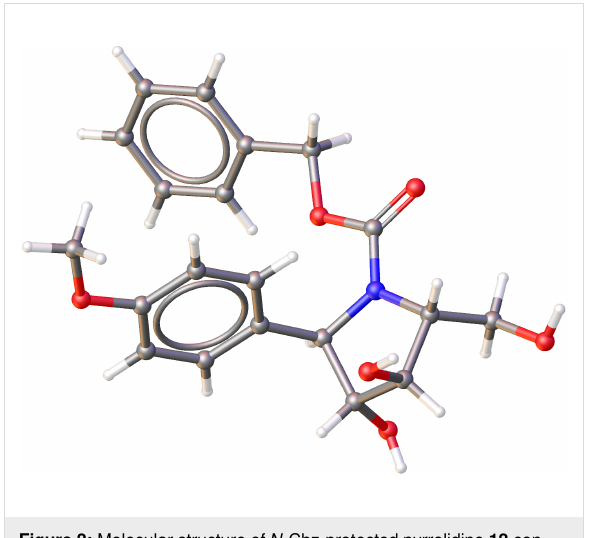
Figure 2: Molecular structure of N -Cbz-protected pyrrolidine 12 con- firmed by single-crystal X-ray crystallographic analysis, proving the same relative configuration as that in natural codonopsinol